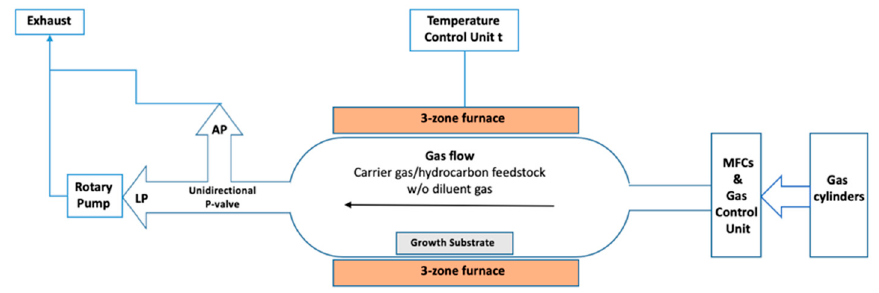
Figure 2. Schematic diagram of a typical hot-wall horizontal tube-furnace CVD system (LP: low pressure, AP: atmospheric pressure).